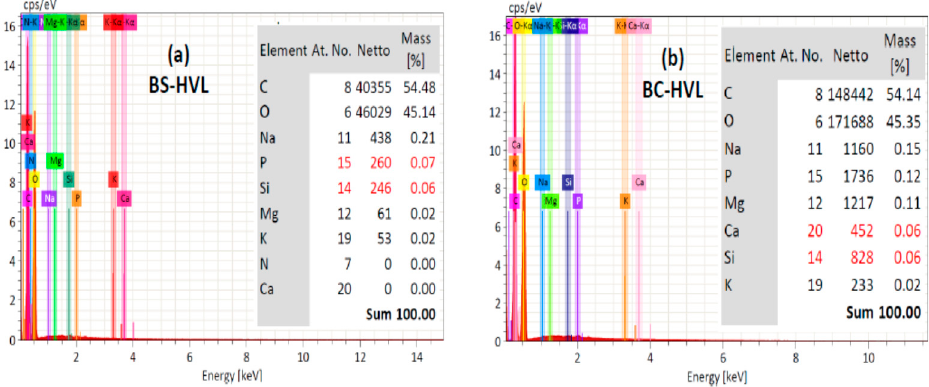
Figure 5. EDXA (energy dispersive X-ray analysis) diffractograms after adsorption of the dye on BS-HVL ( a ) and BC-HVL ( b ).